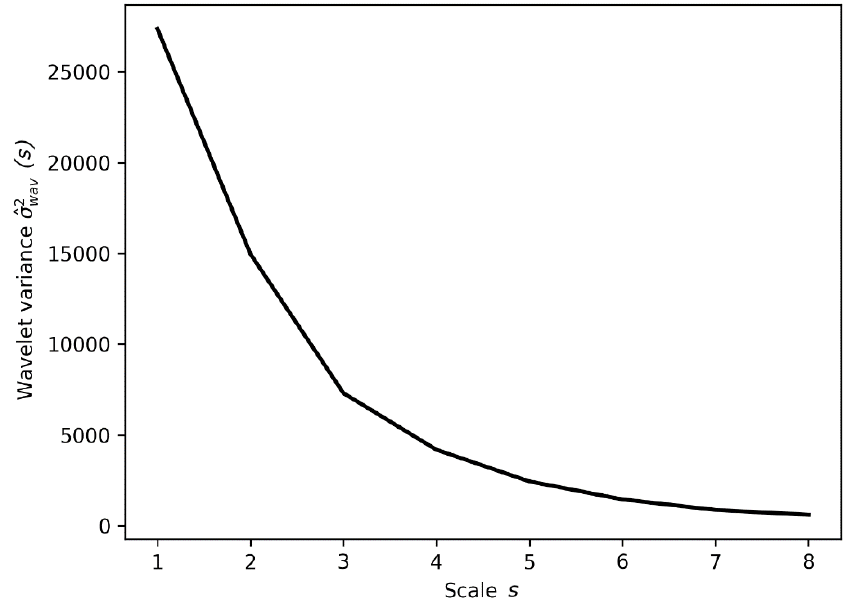
Figure 6. Wavelet variance of the coefficients shown in Figure 5.